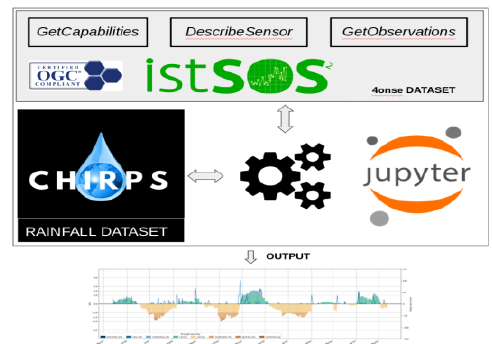
Figure 6. Algorithm for the SPI